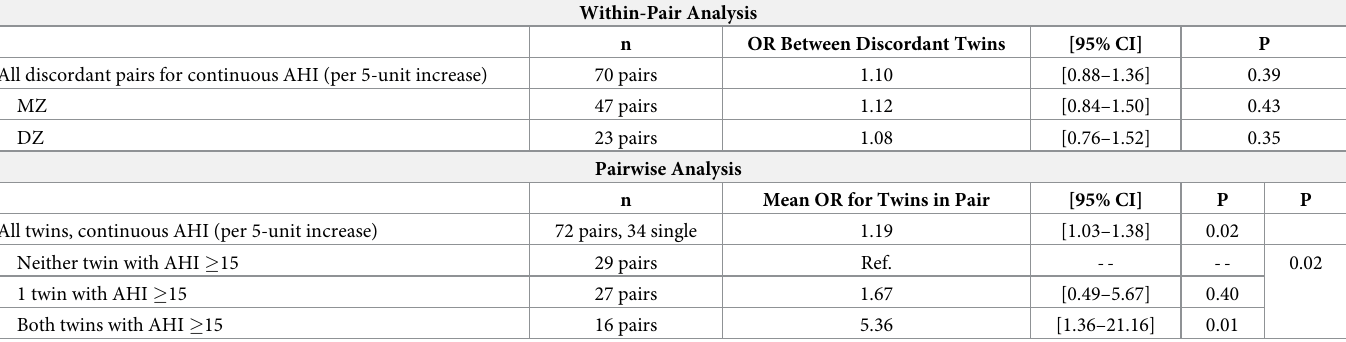
Table 4. Within-pair and between-pair relationships between the Apnea-Hypopnea Index (AHI) as a continuous variable and total severity score � 100, in twins dis- cordant for AHI (at least 5-point difference). The pairwise analysis is also shown for AHI status as a categorical variable. Within-Pair